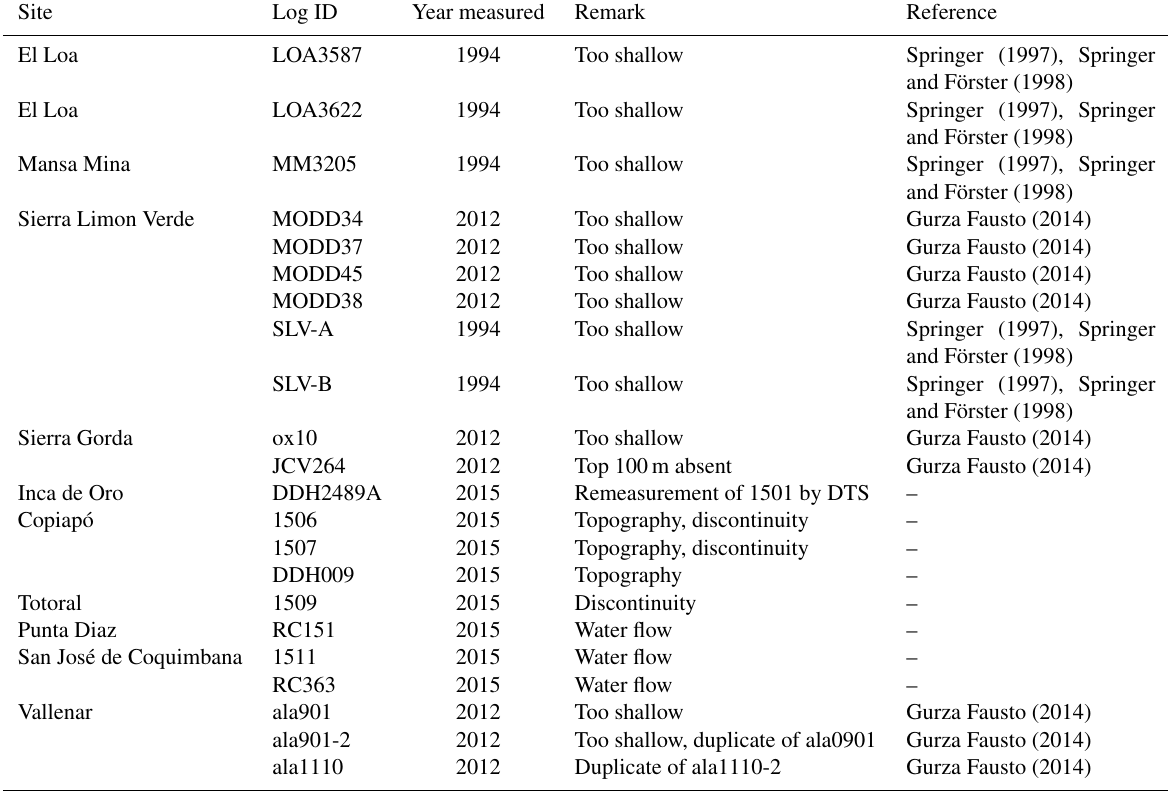
Table A1. Technical information concerning boreholes not suitable for this